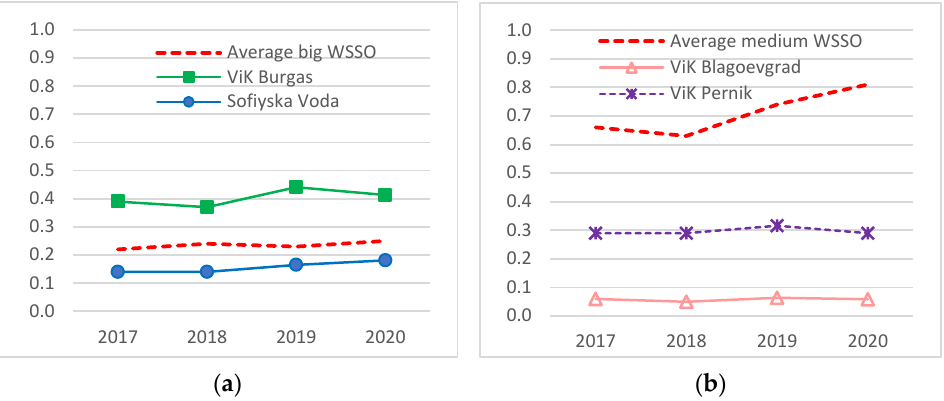
Figure 6. Energy demand in kWh per m 3 for water intake, treatment, and distribution: ( a ) Sofiyska Voda and ViK Burgas; ( b ) ViK Blagoevgrad and ViK Pernik.